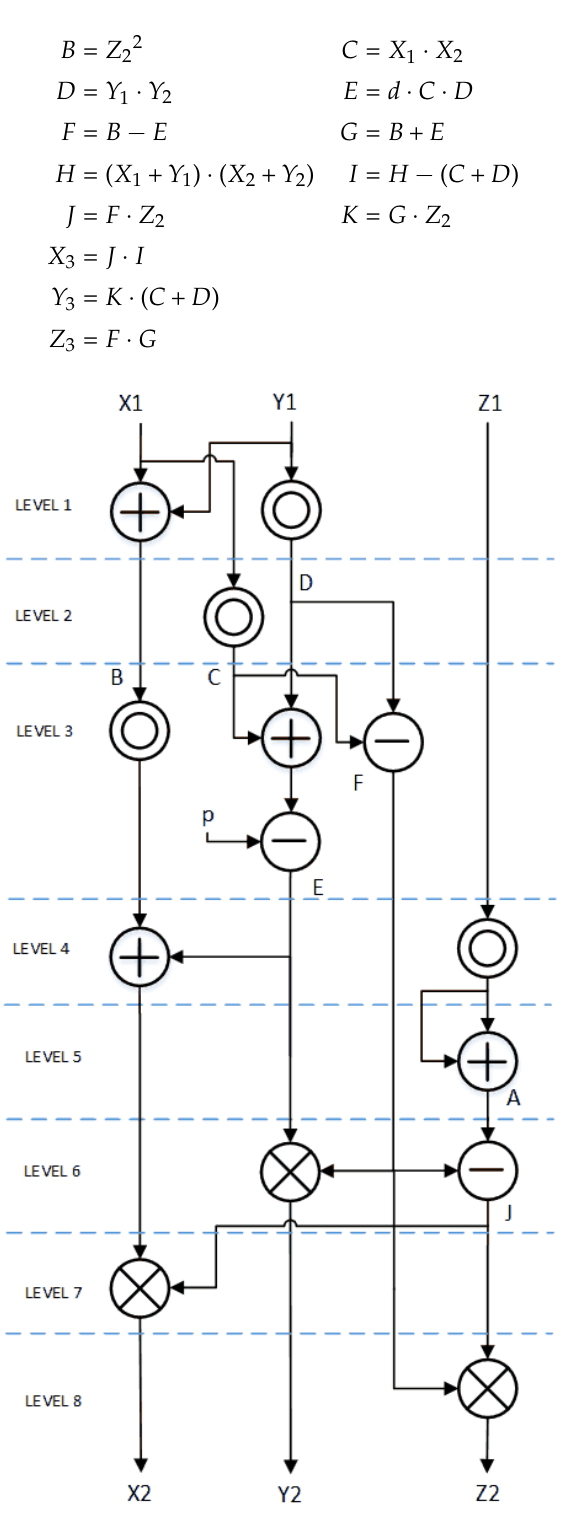
Figure 1. ED25519 Point doubling flow